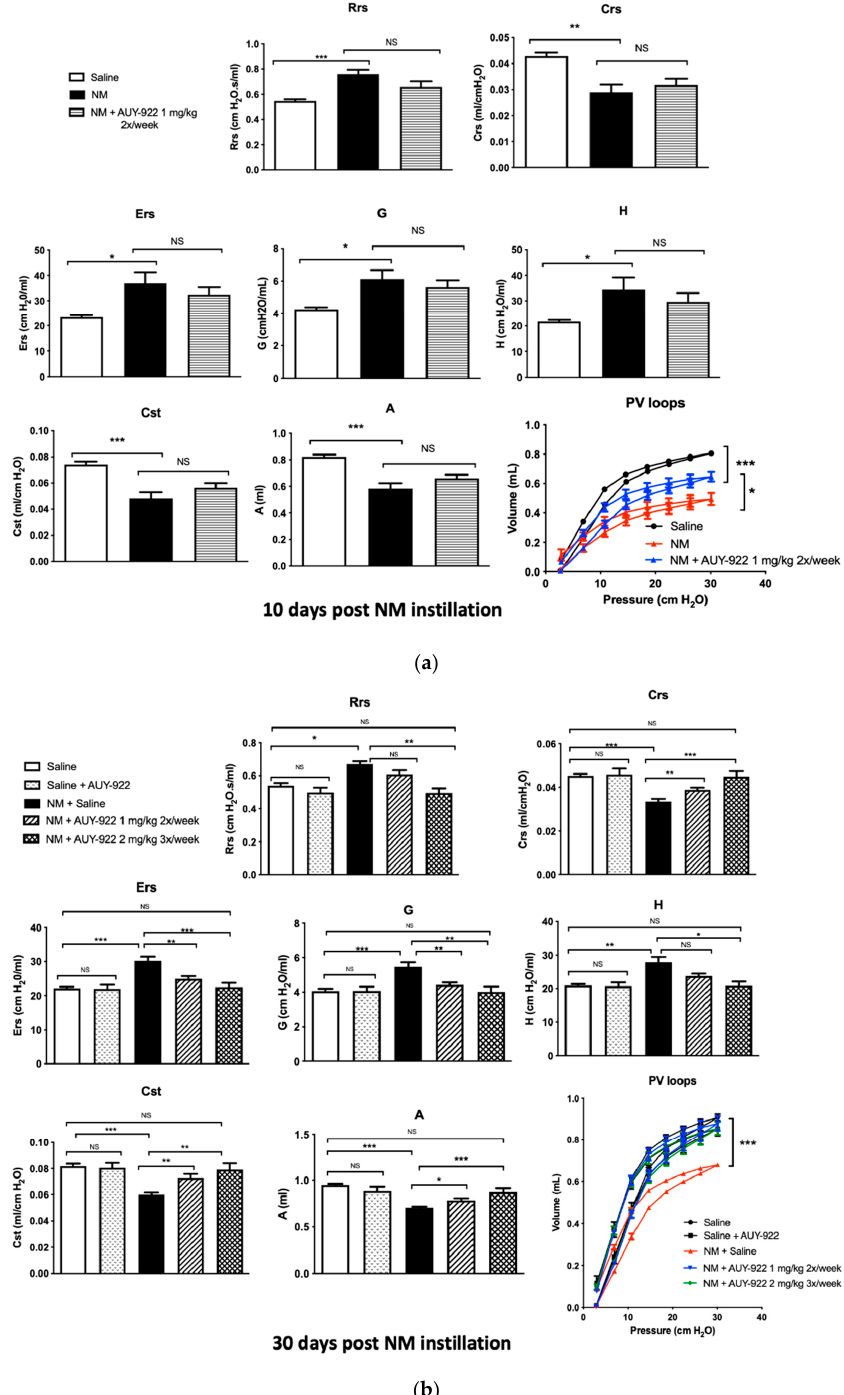
Figure 9. E ff ect of AUY-922 on NM-induced alterations in lung mechanics. Total respiratory system resistance (Rrs), total elastance (Ers), tissue elastance (H) and damping (G), increased, while respiratory system compliance (Crs), static compliance (Cst) and inspiratory capacity (A) decreased, compared to control mice in all groups, instilled with 0.625 mg / kg NM ( a , b ). The inhibitor had a significant impact on preventing a downward shift of pressure volume (PV) loops at 10 and 30 days after NM. Mice receiving AUY-922 for 30 days showed significant improvement in the values of all parameters studied, at both 1 mg / kg and 2 mg / kg dosages (B). Means ± SEM; n = 4 mice per group; *: p < 0.05, **: p < 0.01, ***: p < 0.001, NS: not significant, with ANOVA and